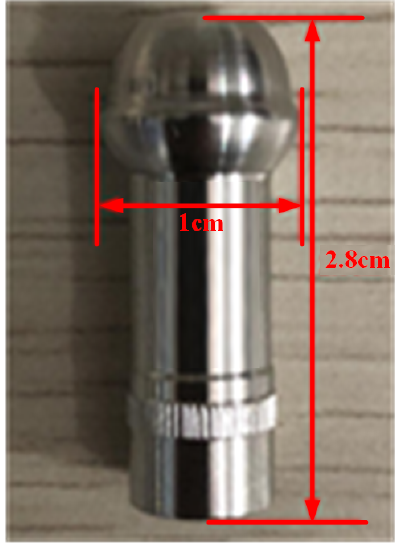
Figure 8. Automobile engine